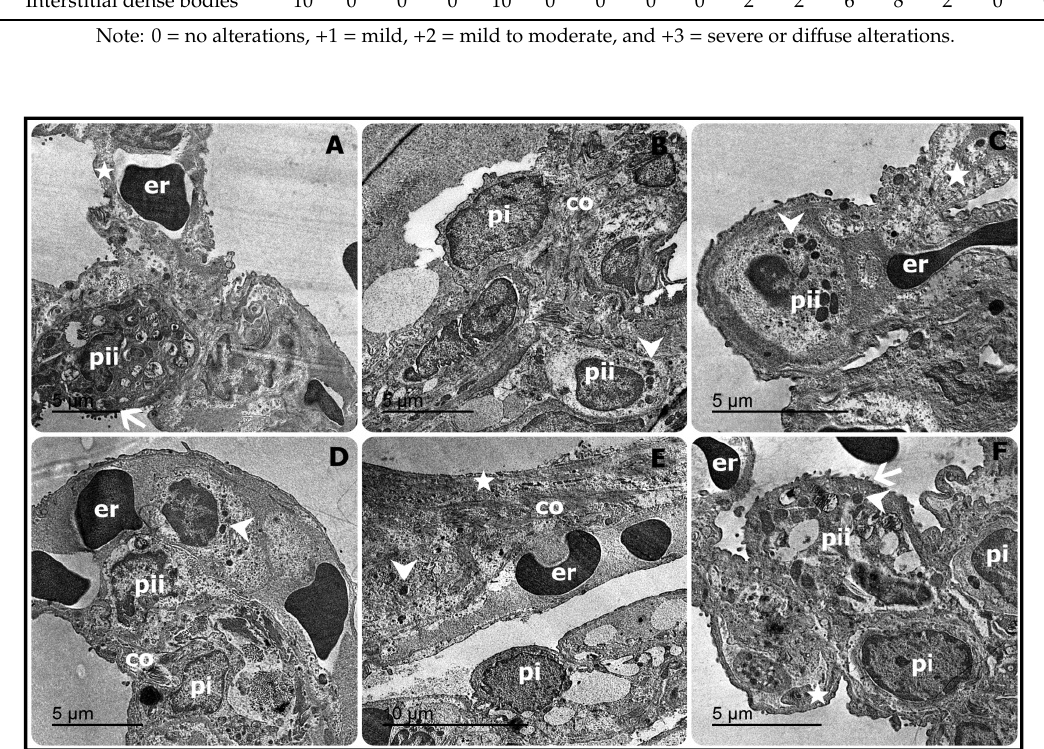
Table 1. Lesion severity grading of the 10 fields of lung sections.